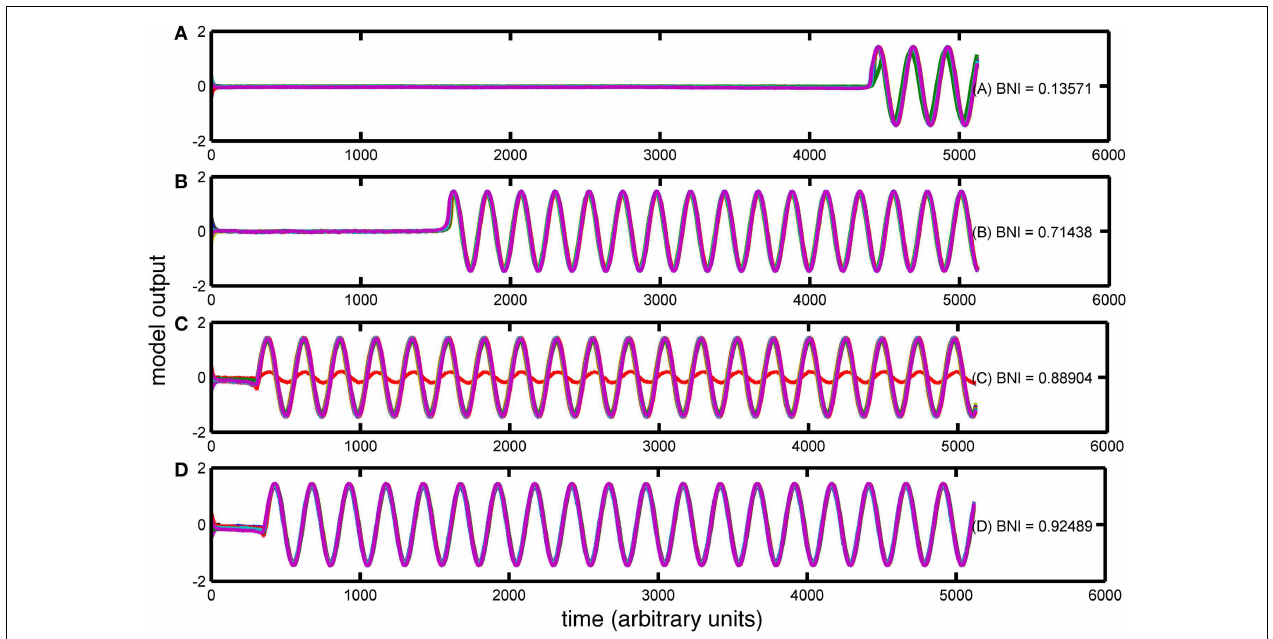
represents the simulation time (arbitrary units) and the y -axis represents the amplitude of the simulated signal. In each case, all 19 channels are overlaid in different